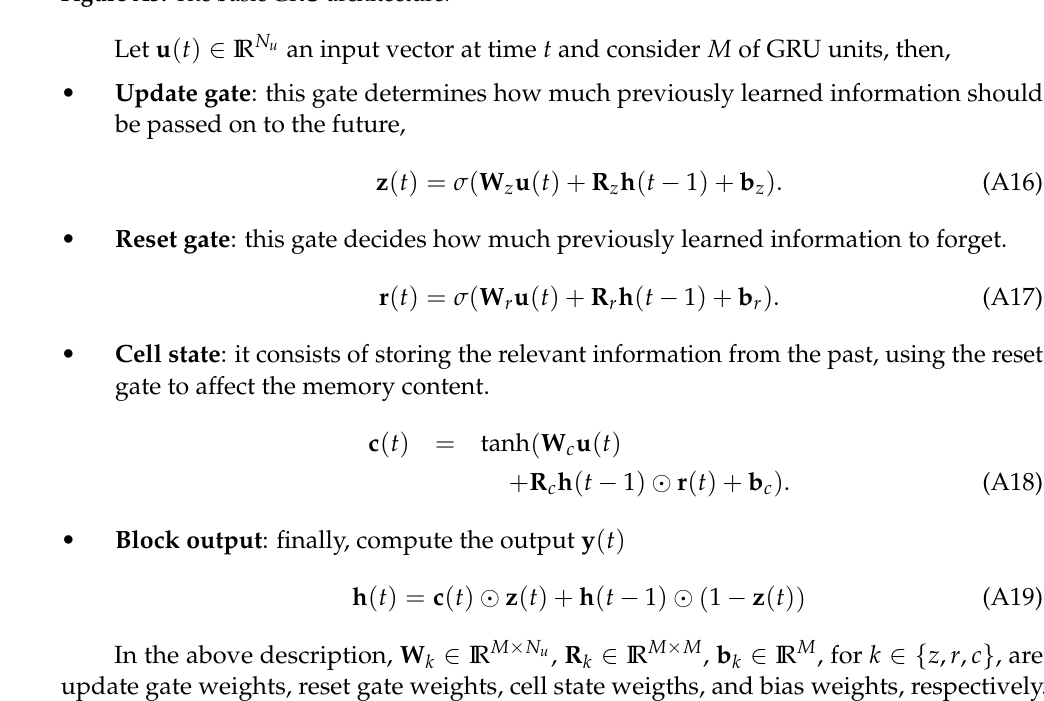
Figure A3. The basic GRU